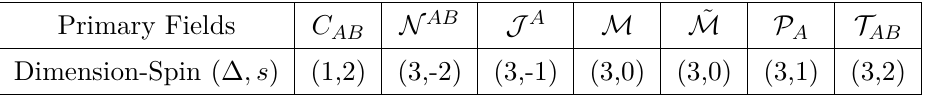
Table 1 . Fields transforming covariantly according to (2.5) under the homogeneous component of